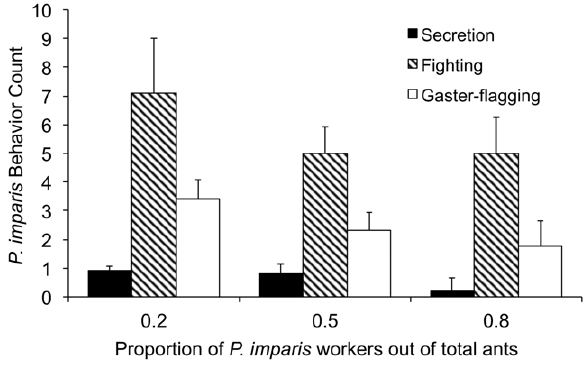
Figure 3. Effect of the relative numbers of L. humile and P. imparis on aggressive behavior. Shown are the mean number of observations per trial of secretion (filled bars), gaster-flagging (hatched bars), and fighting (open bars) in relation to the proportion of P. imparis workers. Each assay was performed with 20 total P. imparis and L. humile workers and N =15 trials for each proportion. Error bars show standard error of the mean.